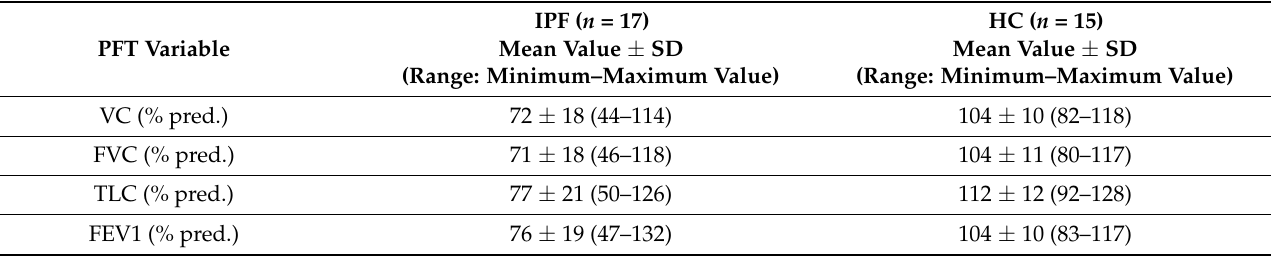
Table 2. Pulmonary function tests (PFT) values at